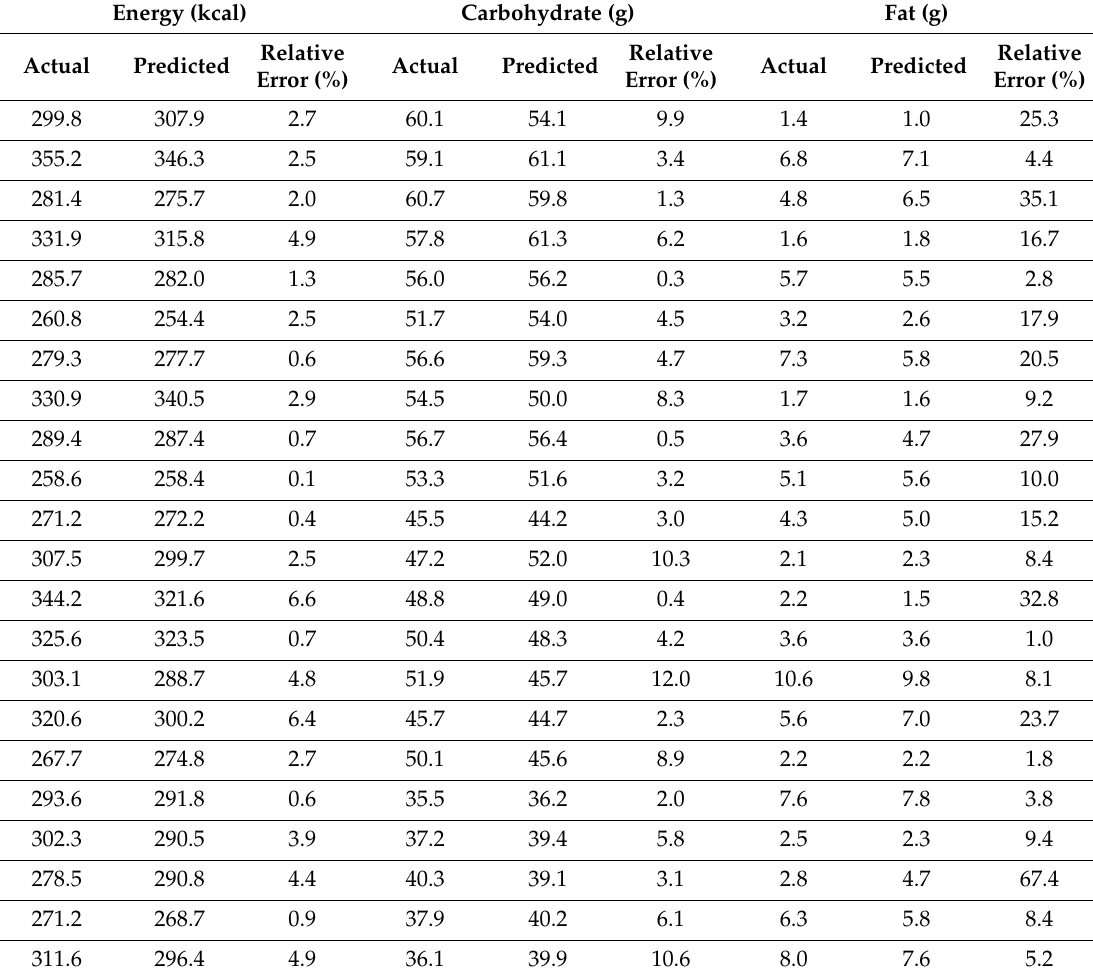
Table 3. The actual and predicted nutritional parameter content and relative error obtained for the test set samples per serving via the individual PLS models developed for energy, carbohydrates and fat. Carbohydrate (g) Fat